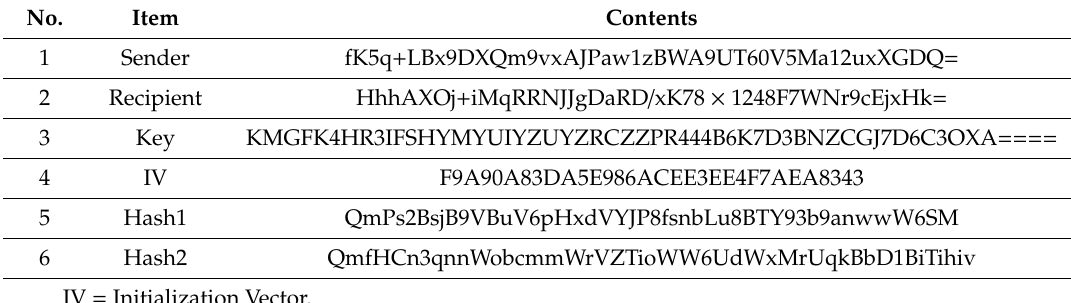
Table 3. The contents of the transaction for CDM.